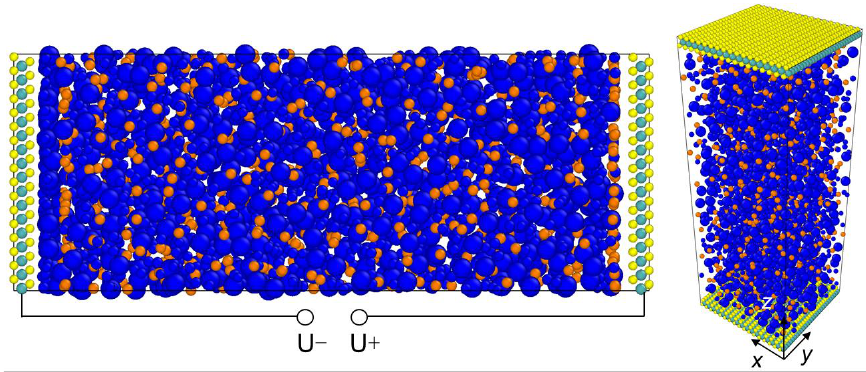
Figure 1. MD simulation model of [BMI + ][PF 6 − ] electrolyte on the MoS 2 electrode. Blue and orange colors present the cation and anion, respectively. Green and yellow colors denote Mo atom and S atom, respectively.